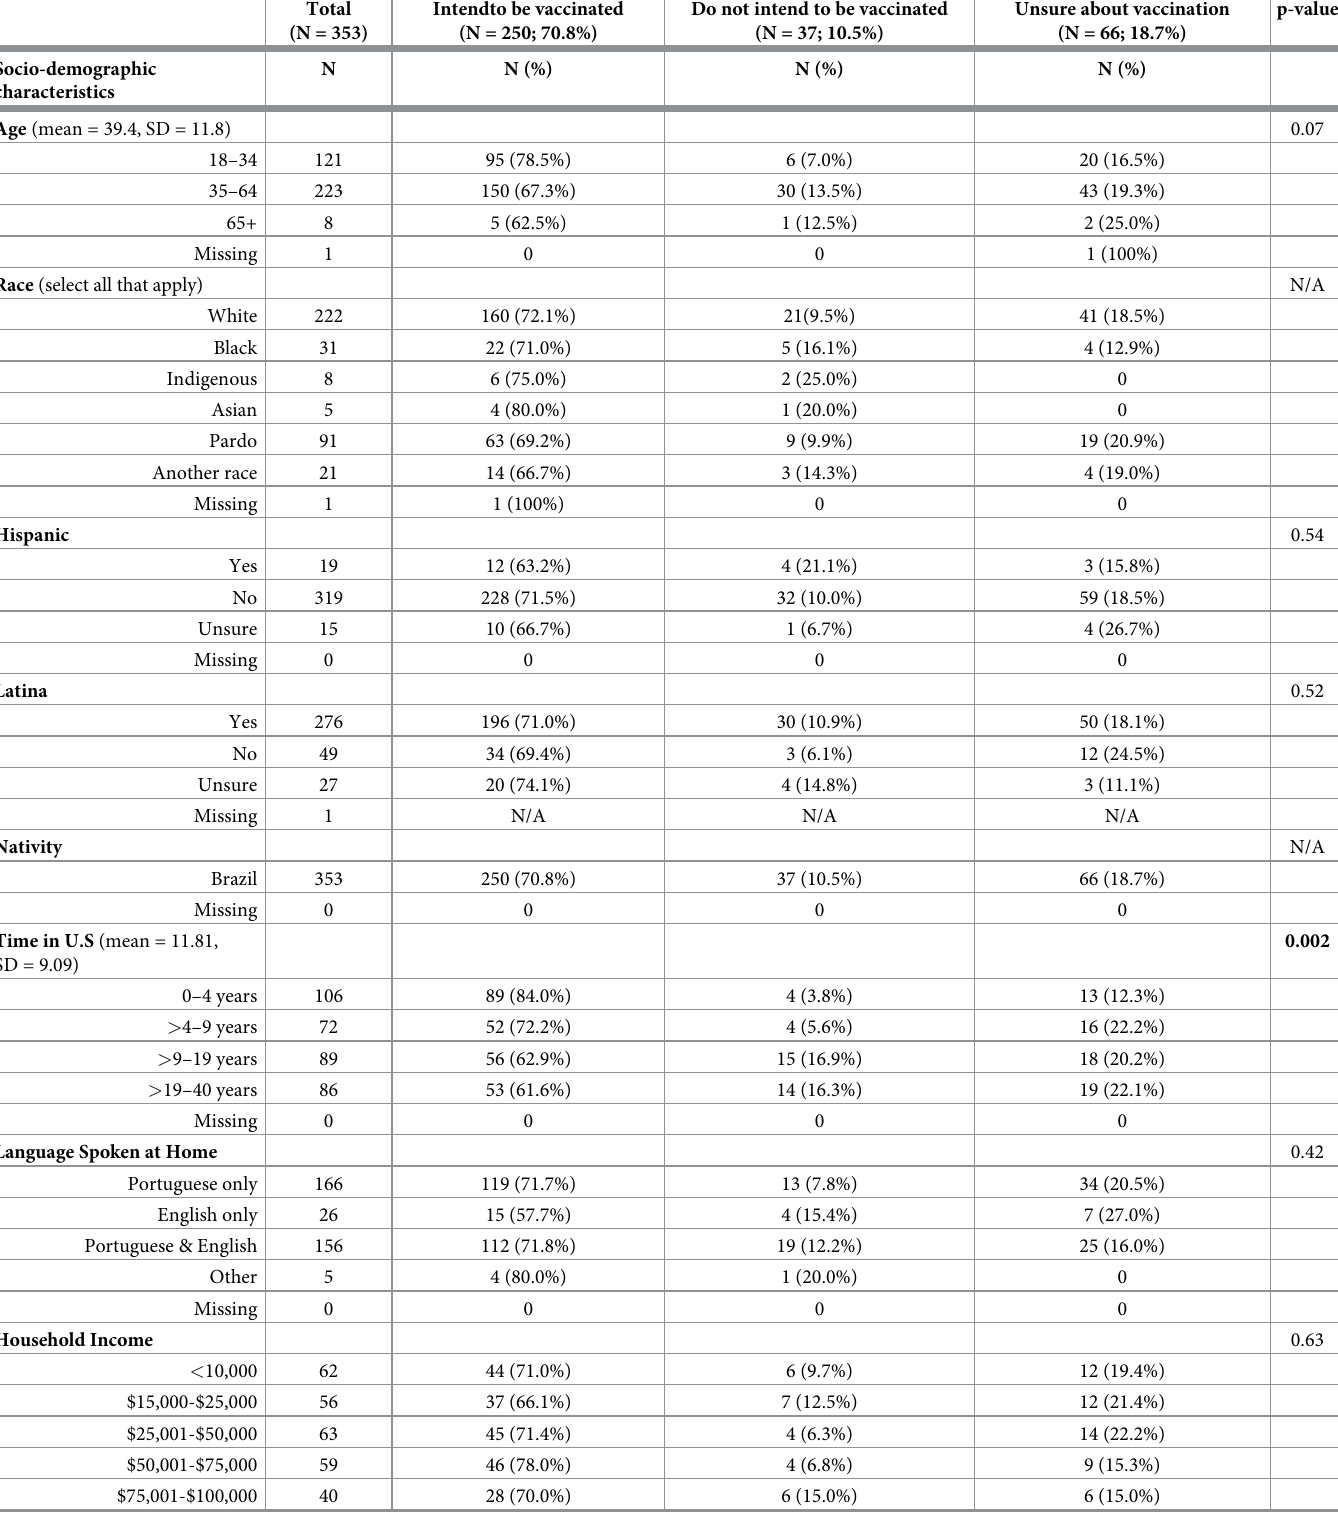
Unsure about vaccination p-value (N = 66; 18.7%)